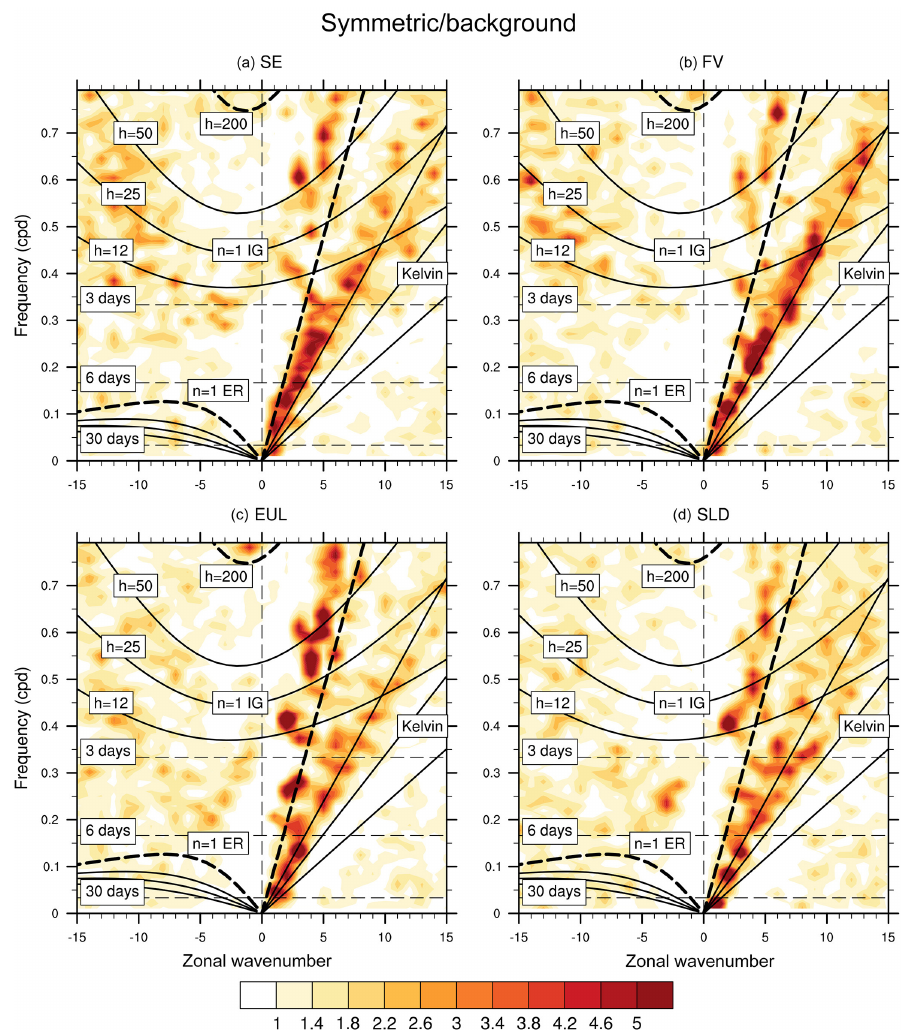
Figure 16. Wavenumber–frequency diagrams for the MITC simulations showing spectral power for the symmetric component of the 100hPa equatorial temperature averaged between ± 15 ◦ for (a) SE, (b) FV, (c) EUL, and (d) SLD. The solid lines show the theoretical shallow-water dispersion curves for the equivalent depths h = 12 , 25, and 50m without a mean background velocity. The thick dashed line is the h = 200m dispersion